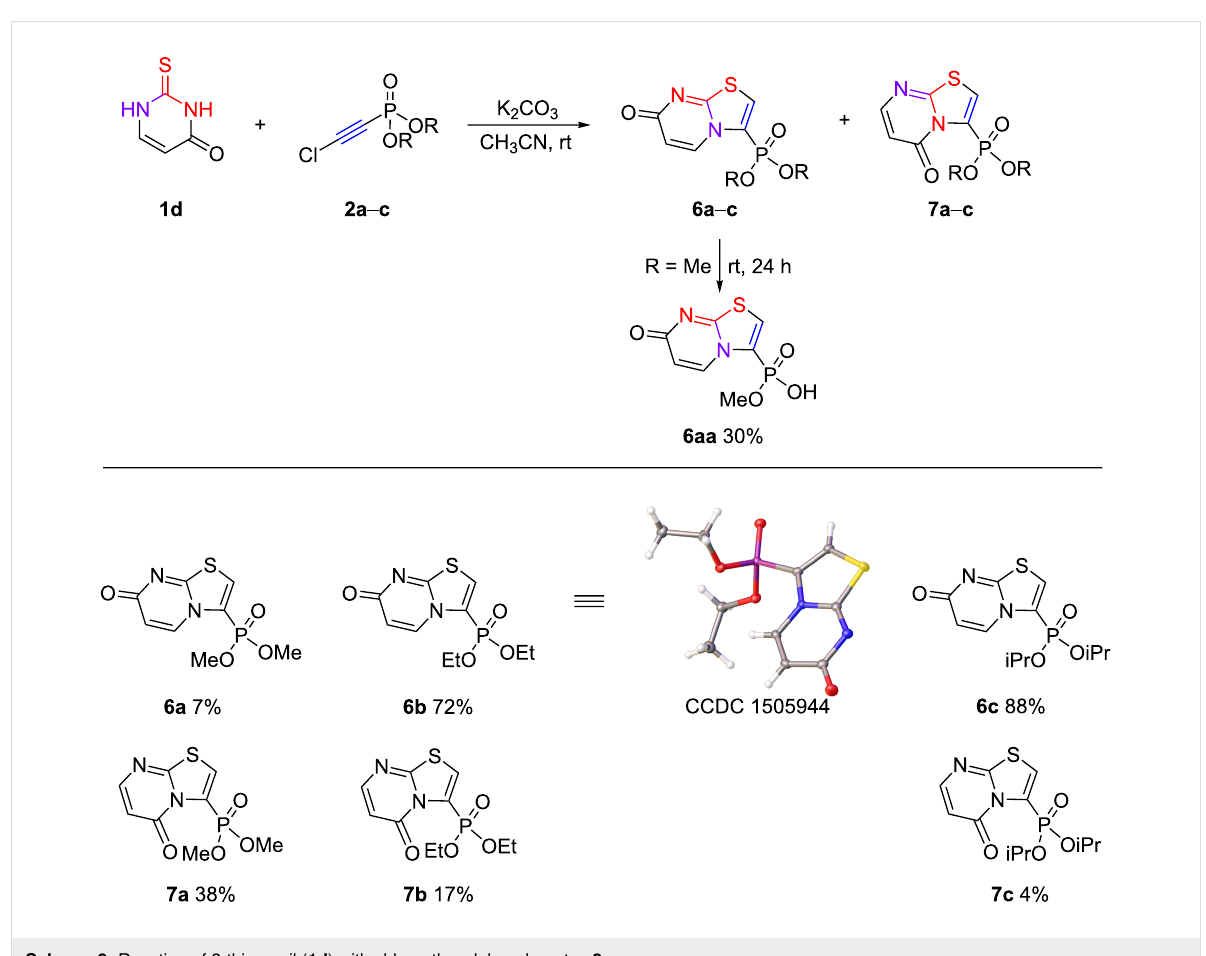
Scheme 8: Reaction of 2-thiouracil ( 1d ) with chloroethynylphosphonates 2a – c